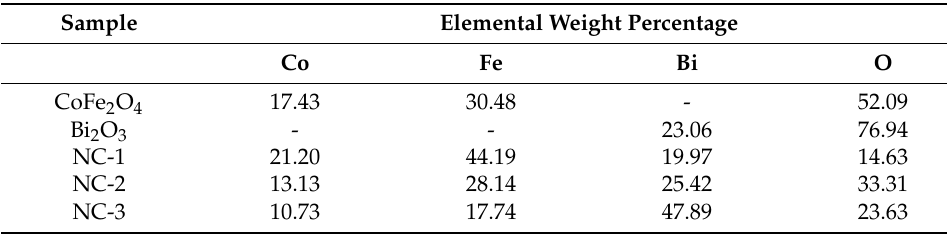
Table 2. EDX elemental data of as-prepared samples.